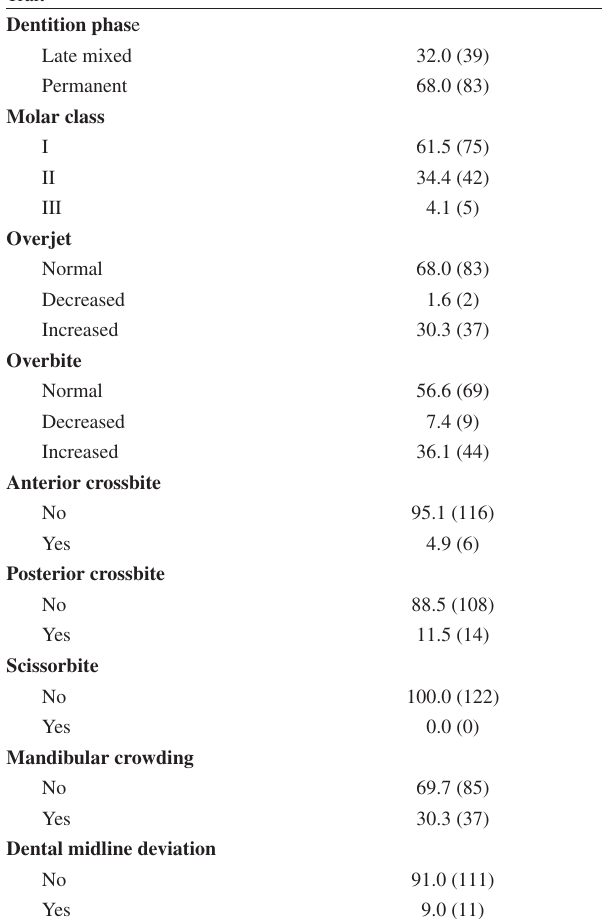
Table 1- Prevalence of occlusal traits as % (count) in the sample (n = 122) Trait